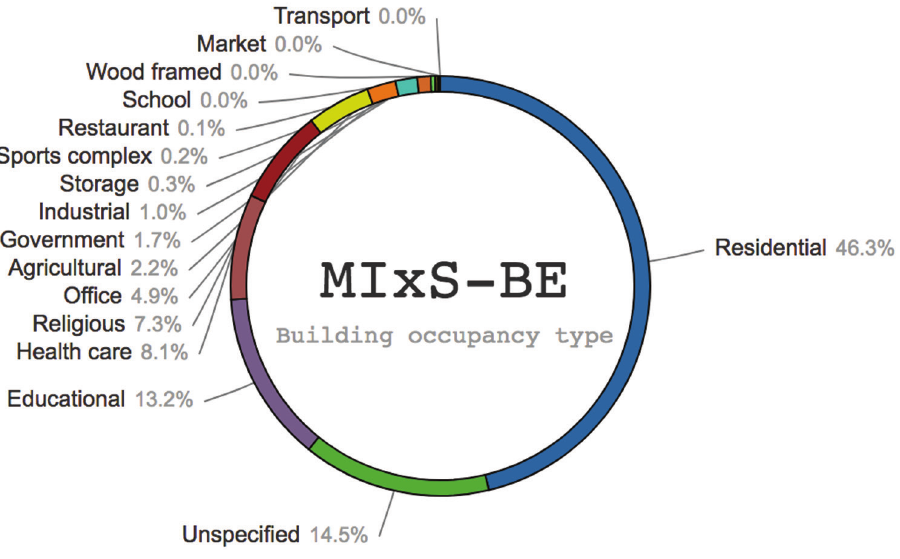
Figure 3. Analysis of the MIxS-BE “building occupancy type” (type of building where the underly- ing sample was taken). The figure is based on Abarenkov et al. (2016) plus the data added during the workshop, such that it indicates the scientific state of ITS-based Sanger-derived sequencing of the built mycobiome as of spring